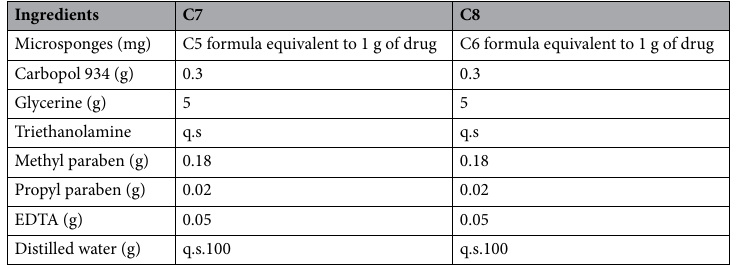
Table 2. Formulae for microsponge loaded gels of CLN-free